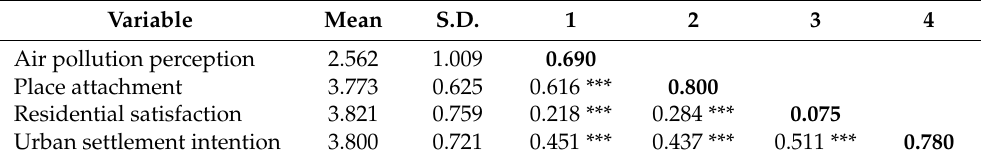
Table 2. Reliability and validity